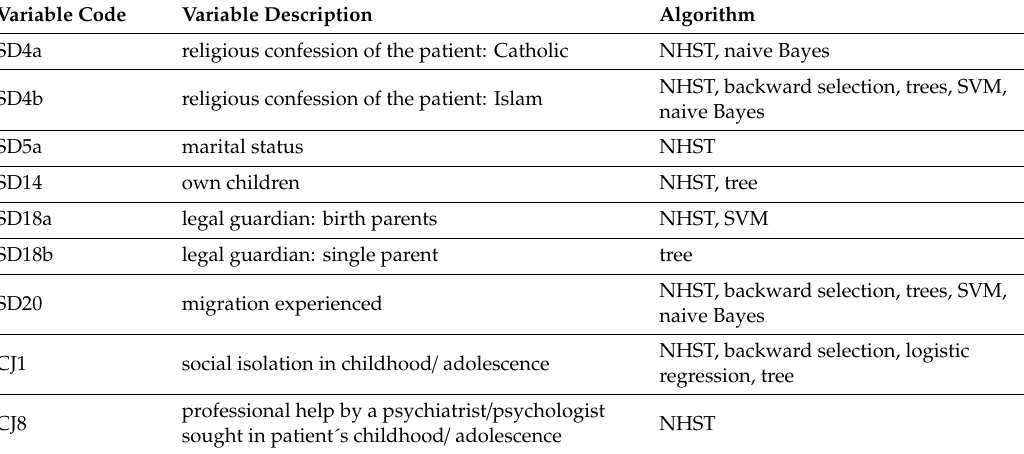
Table A1. Predictor variables identified by at least one machine learning